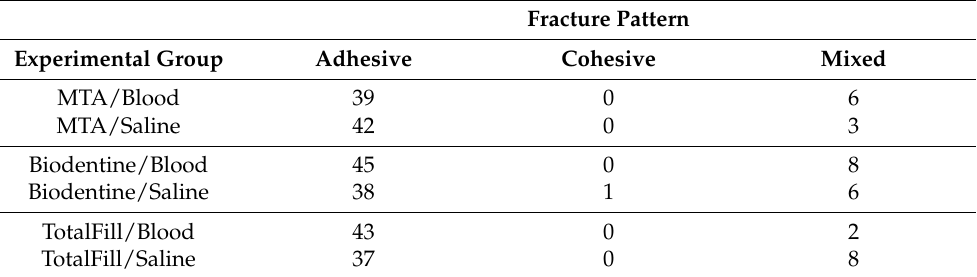
Table 4. Fracture pattern analysis